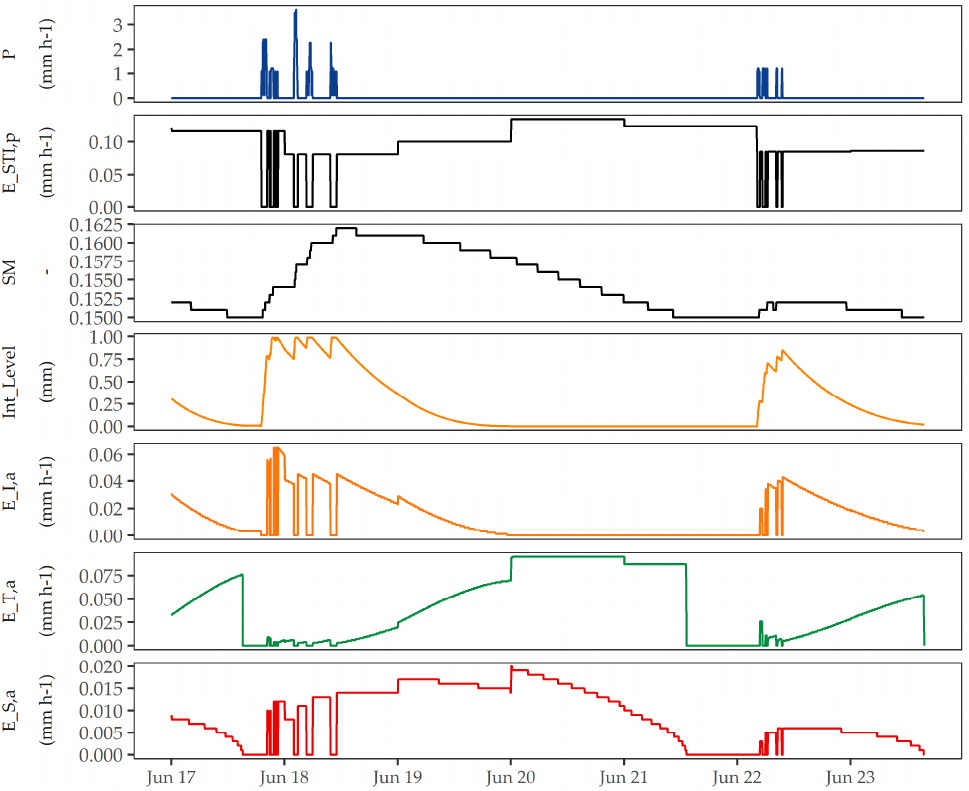
Figure 9. Time series from SWMM-UrbanEVA for ET relevant processes for a one-week period. Precipitation ( P ) and potential evapotranspiration ( E STI , p ) as model input variables; soil moisture (SM), interception storage level (Int_Level), interception evaporation ( E I , a ), transpiration ( E T , a ) and soil evaporation ( E S , a ) as model output variables. Simulation done for St. Arnold with K S = 1, K C = 1, LAI = 2, and WP = 0.15.